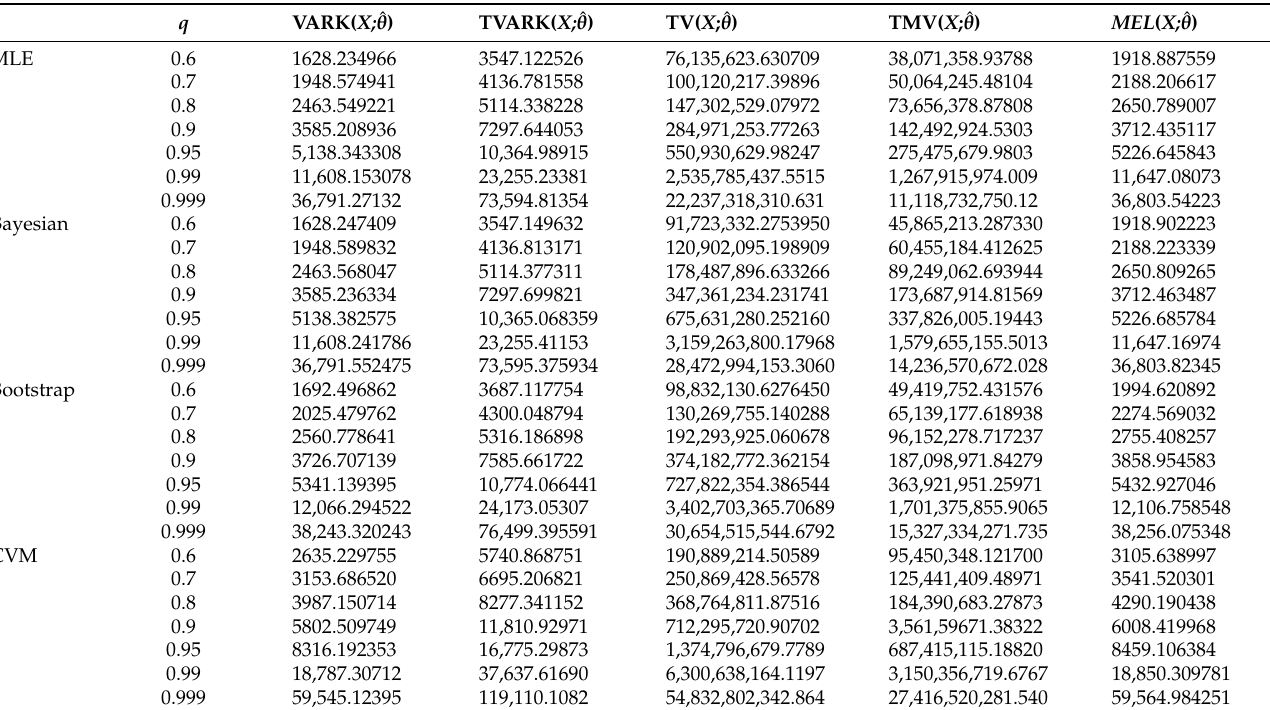
Table 15. The results of the KRIs for the IR under insurance-claims